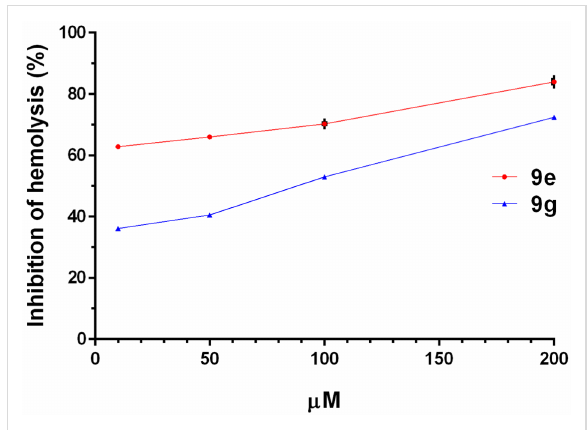
Figure 3: Inhibition of hemolysis (%) on human red blood cells caused by S. aureus ATCC 25923 after being in presence of several concen- trations of compounds 9e and 9g (assay 3). The hemolysis is scored in % of hemolysis relative to the control (hemolysis caused by S. aureus ATCC 25923 in absence of any compound; only DMSO), which was set to 100%. Two independent experiments were performed in dupli- cate. Error bars represent standard